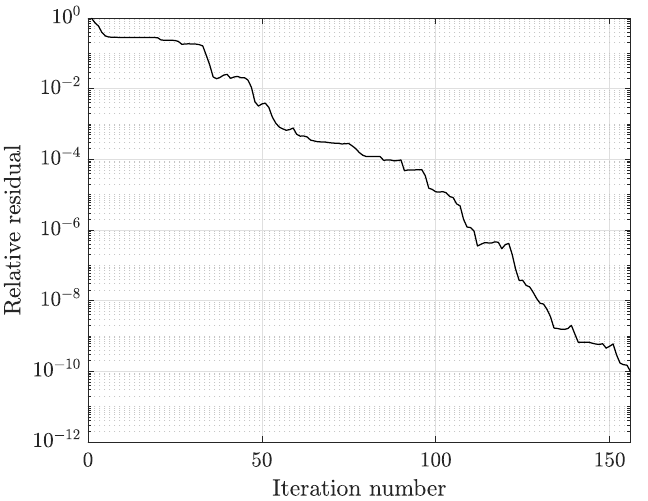
Figure 2. Convergence pattern of the TFQMR solver with SSOR preconditioning at 100 Hz (CM-BEM software with R-SVD compression; coarsest mesh: 25,157 tets).